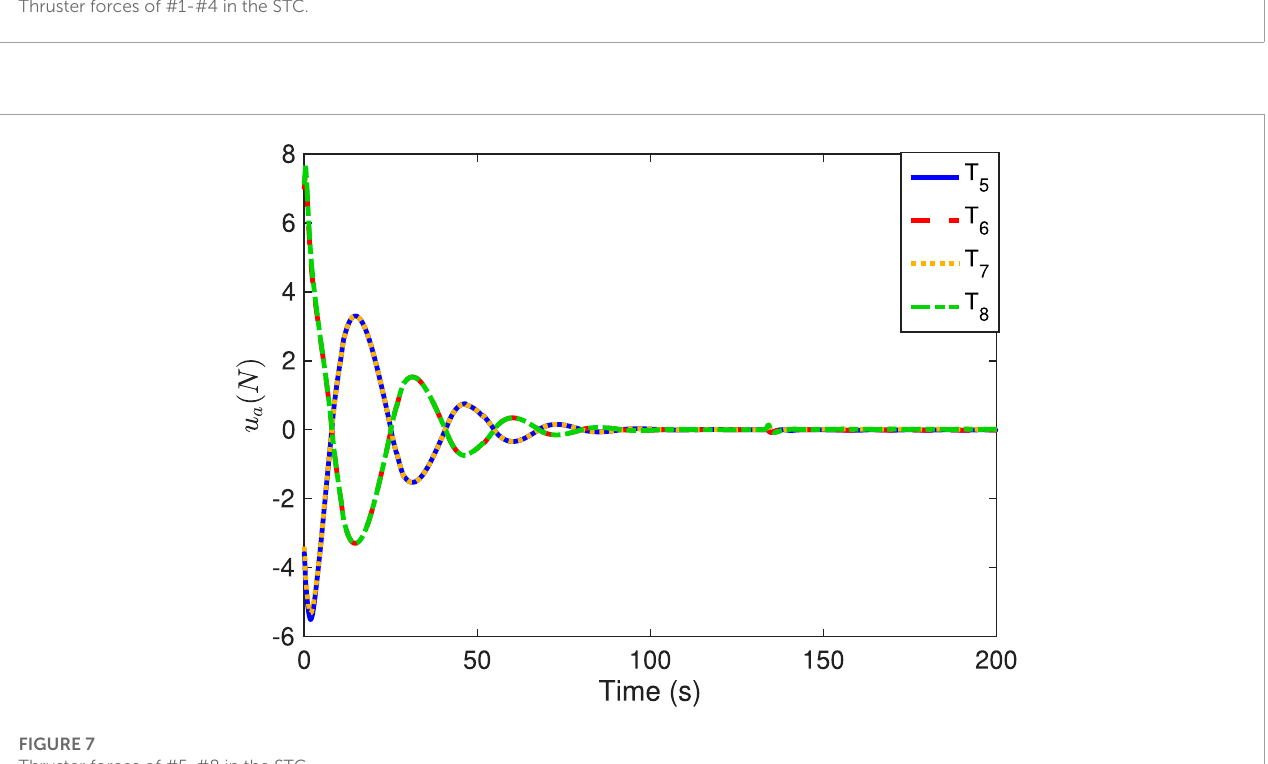
system governed by (8) . The TSMC (Dong et al., 2016) and non- singular fast terminal sliding mode control (NFTSMC) (Sun et al., 2022) are carried out for comparison, where the identical initial values are selected for different controllers. In particular, the control parameters are chosen for purpose of the same settling time. To eliminate the chattering phenomenon caused by the